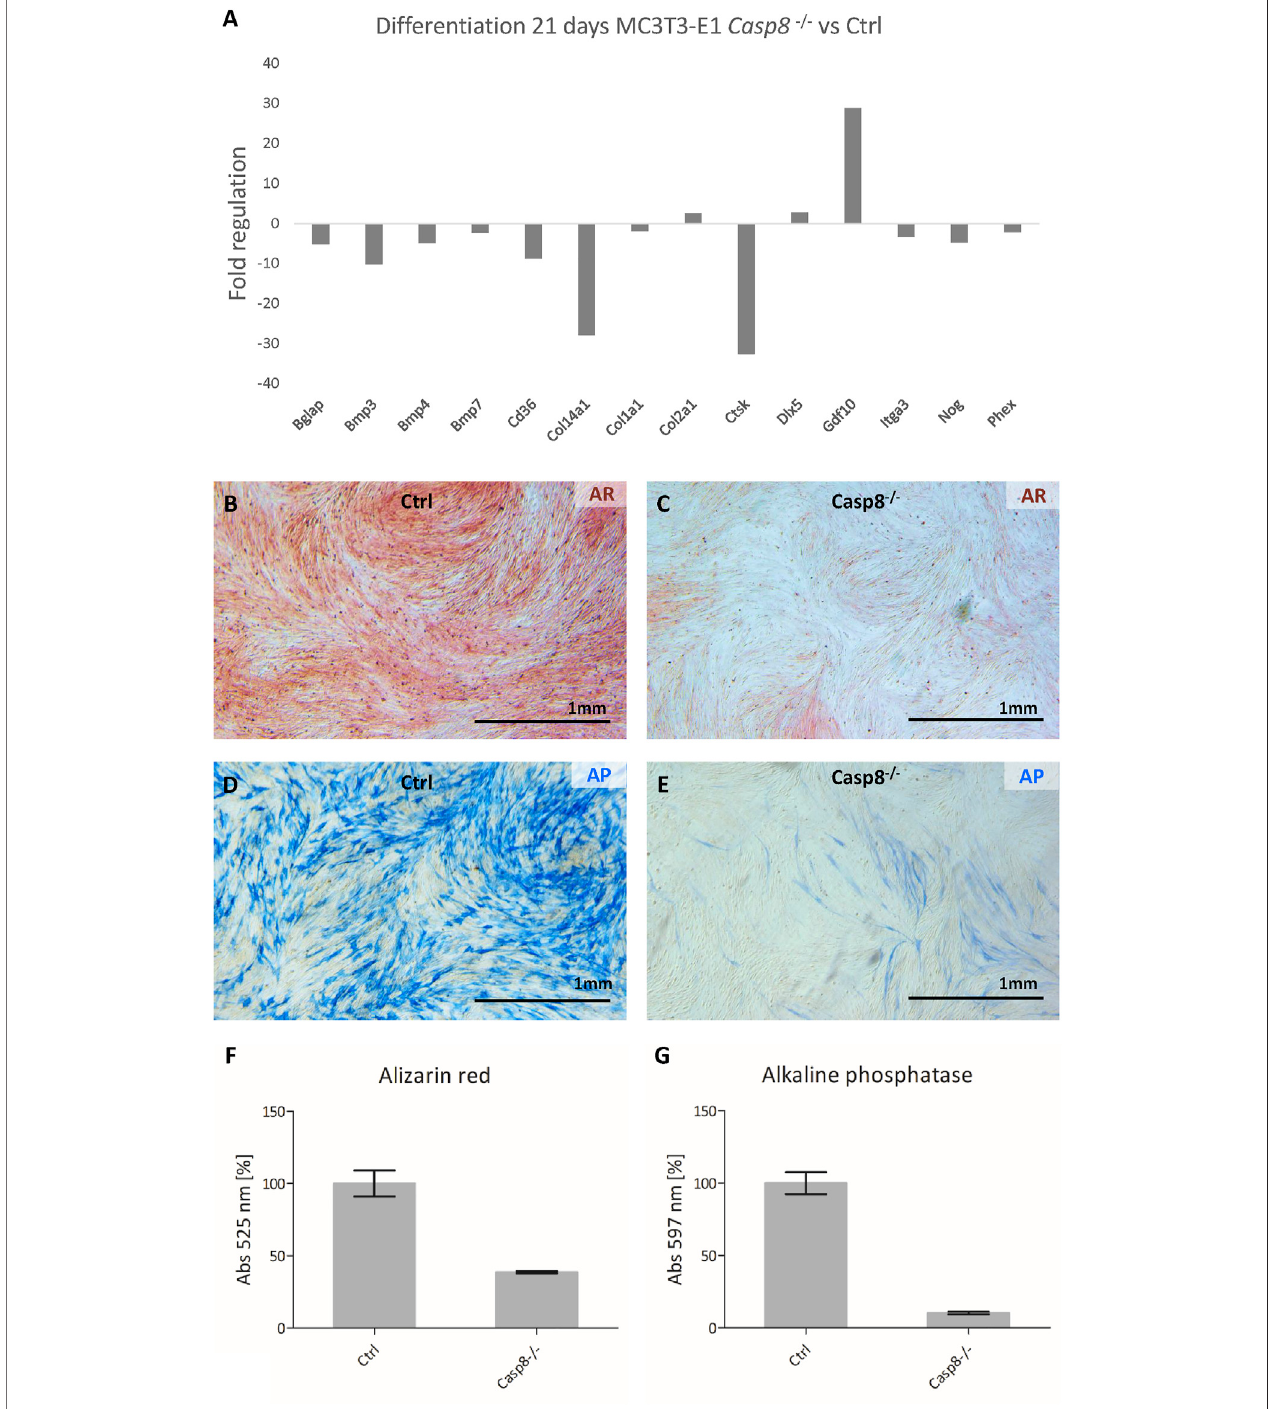
FIGURE 5 | PCR Array analysis of osteogenesis-related gene expression after 21 days of differentiation in Casp8 − / − compared to control cells (A) . Alizarin red staining of mineralization (red) in control (B) and Casp8 − / − (C) differentiated cells. Alkaline phosphatase activity (blue) in control (D) and Casp8 − / − (E) differentiated cells. Scale bar = 1 mm. Spectrophotometric analysis of alizarin red (F) and alkaline phosphatase activity (G) in cell lysates of stained control and Casp8 − / − differentiated cells.